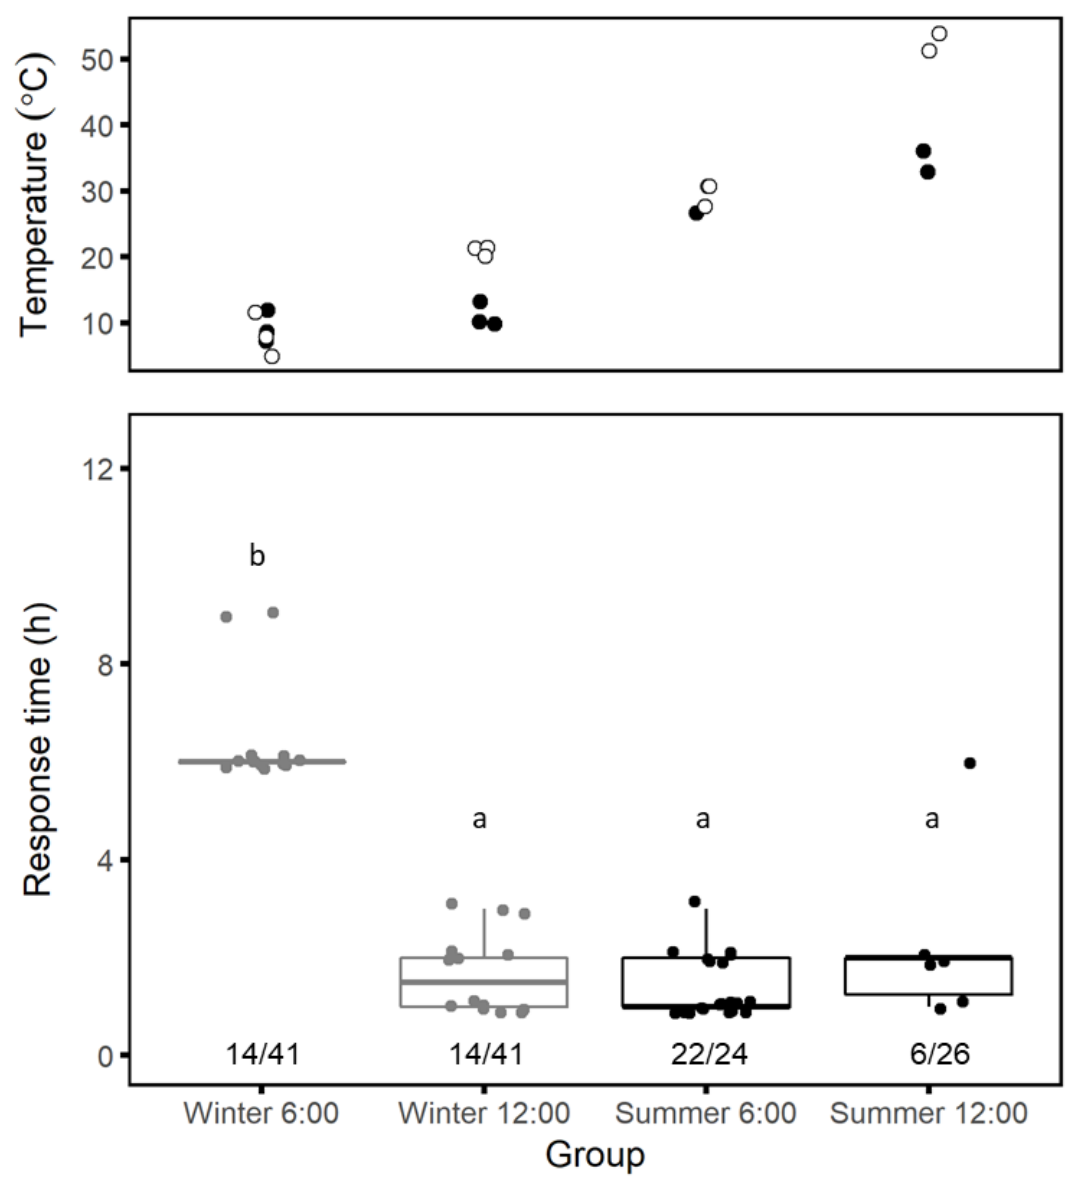
Figure 6. Soil temperatures ( top ) and Lycosa hyraculus response time to trapdoor removal ( bottom ) at different times of day and in different seasons (winter in gray, summer in black). Soil surface temperatures (white) and temperatures at 100 mm depth (black) at the beginning of each trial were measured at the Jacob Blaustein Institutes for Desert Research meteorology station. We defined response time, t web,h , as the time in hours from when we removed a trapdoor to when we first observed a mesh in the burrow entrance. The fraction of spiders that spun silk in their burrow entrances out of all spiders whose trapdoors were removed is indicated below the boxplots. Individual data points are overlaid on the boxplot to better visualize variance. The thick horizontal line is the median, and the lower and upper hinges correspond to the 1st and 3rd quartiles (overlaid by the median in some cases here). The whiskers extend to the farthest value within 1.5 times the inter-quartile range from the median. Groups with different letters are significantly different (Tukey’s post-hoc test, p < 0.05).